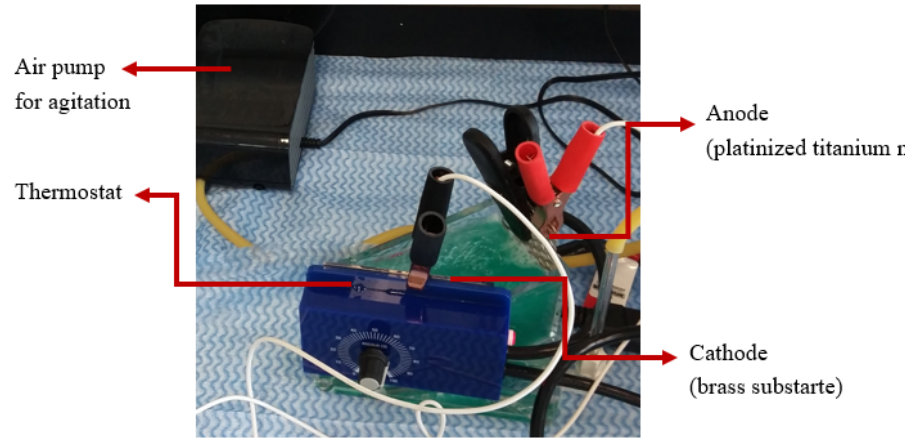
Figure 3. Image of the Hull cell setup equipped with thermostat and air pump.